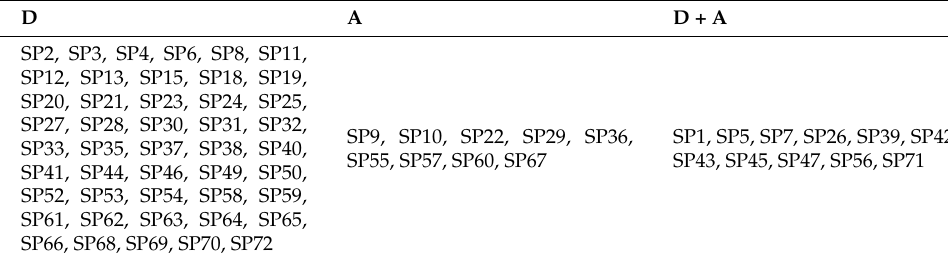
Table 10. Selected papers and SPL